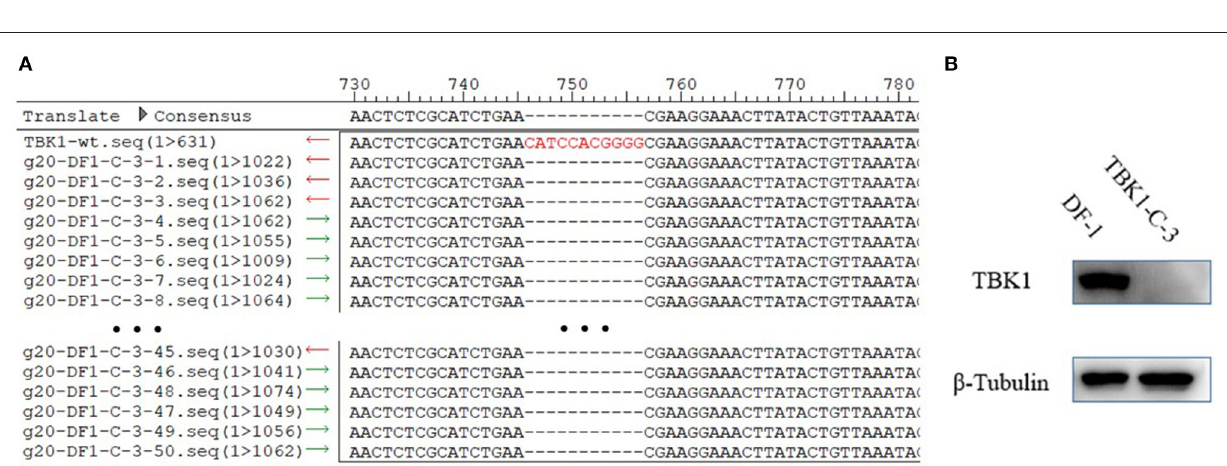
FIGURE 4 | The chTBK1 knockout cell line was stable. (A) Sequencing results for the regions of g20-DF-1-TBK1-C3 cells targeted using CRISPR/Cas9. Alignment of DNA sequences between the wild-type and the g20-DF-1-TBK1-C3 cells showed homozygous mutation with an 11-bp deletion. (B) DF-1 cells and g20-DF-1-TBK1-C3 cells were lysed and analyzed using Western